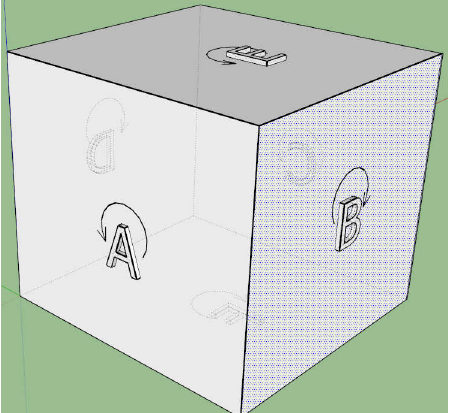
Figure 20: Inconsistent orientation of polygons